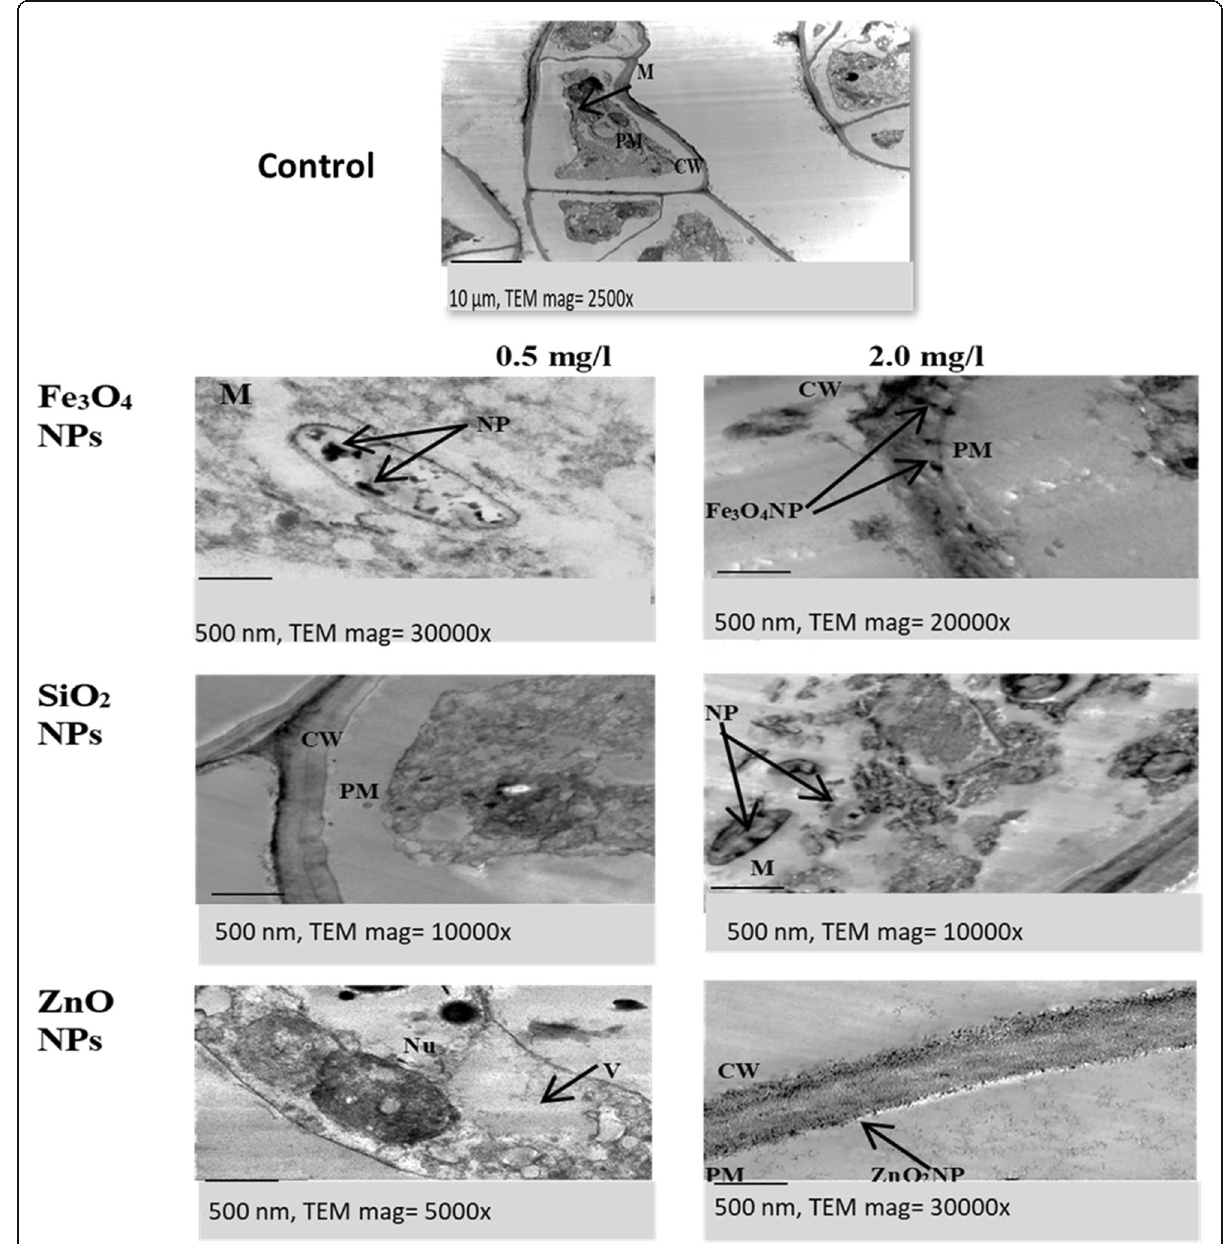
Fig. 6 TEM images of 45-day-old callus of Salvadora persica treated with 0.5 and 2 mg/l of Fe 3 O 4 , SiO 2 , or ZnO nanoparticles and the control. On each image, the scale bar and the magnification power. Abbreviations on images: CW cell wall, M mitochondria, NP nanoparticle, Nu nucleus, P plasma membrane, V